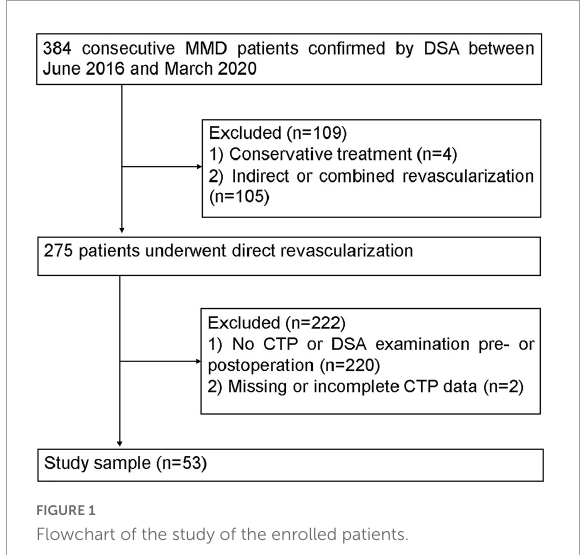
FIGURE1 Flowchart of the study of the enrolled patients.